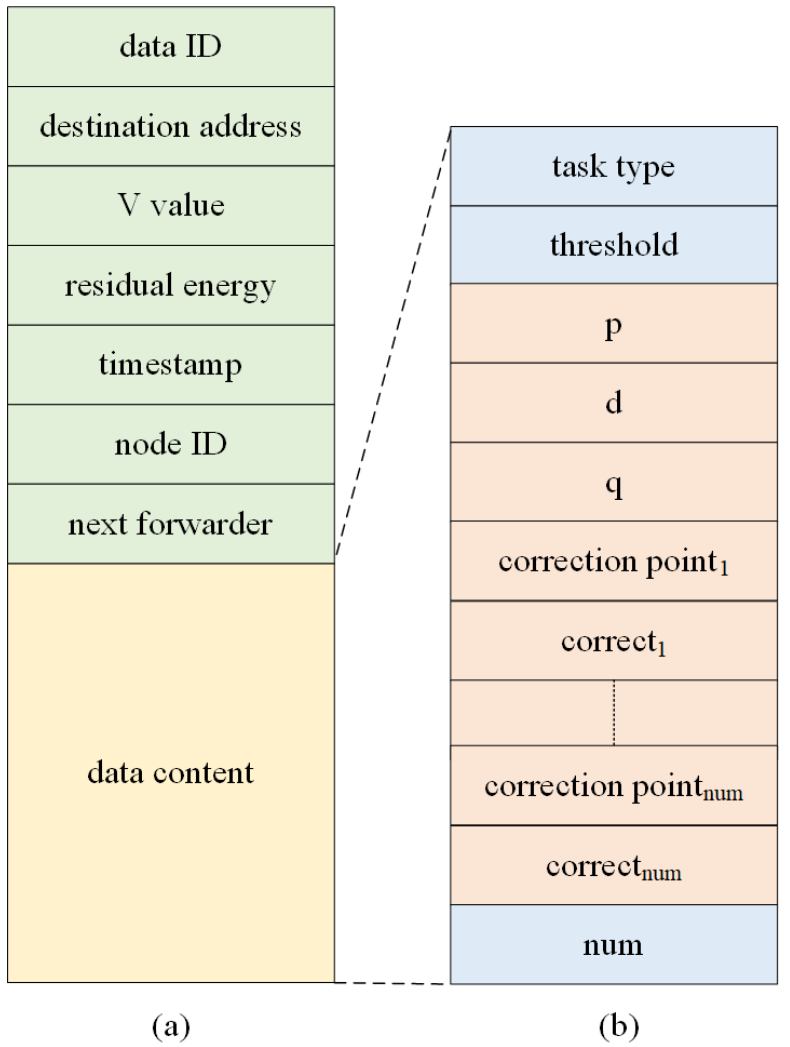
Figure 6. RL-ADTA packet structure. Figure ( a ) shows the composition of RL-ADTA package. Fig- ure ( b ) shows the constituent fields of the ‘data